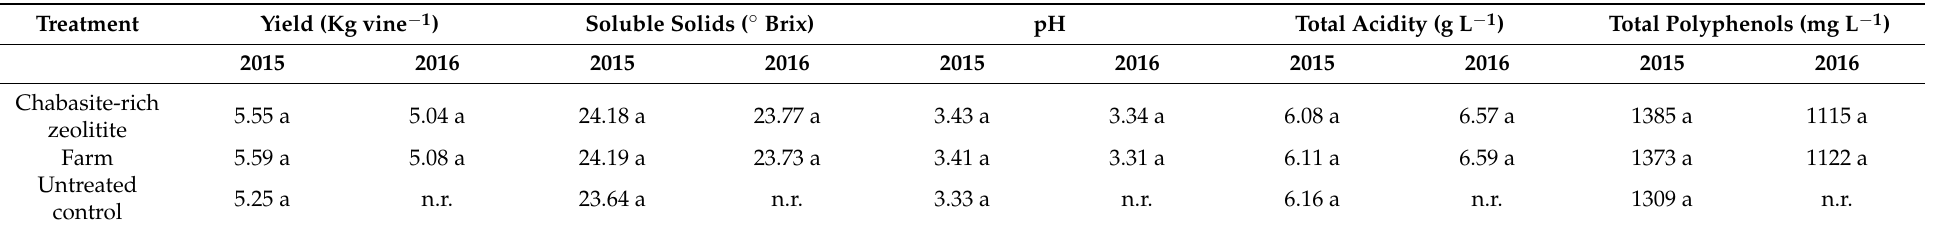
Table 5. Mean yield and main grape composition parameters recorded in 2015 and 2016 at harvest in Montepulciano vines of the Ari vineyard treated with Italian copper chabasite-rich zeolitite and farm products.